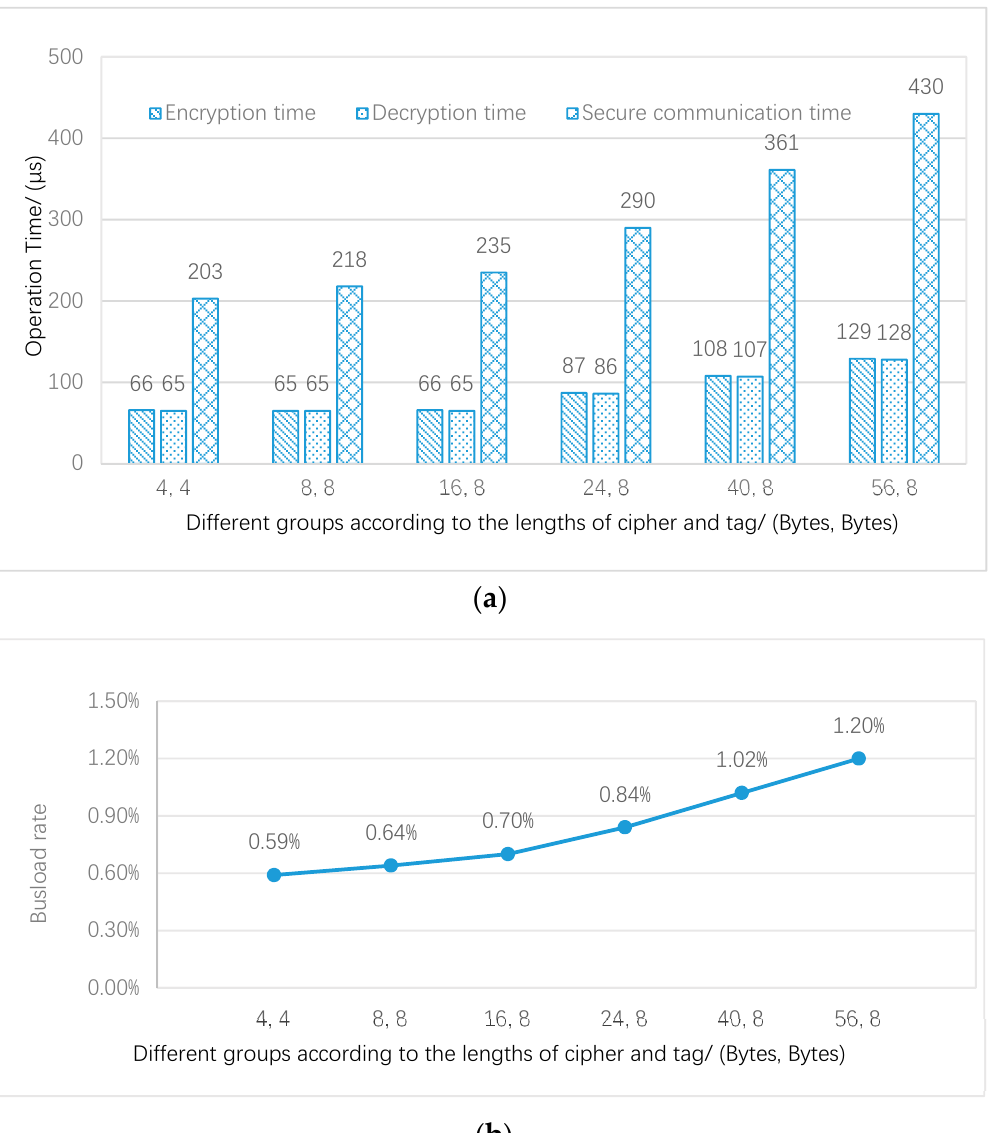
Figure 12. Execution time of algorithm and secure communication ( a ) and bus load rate on the CAN FD ( b ).